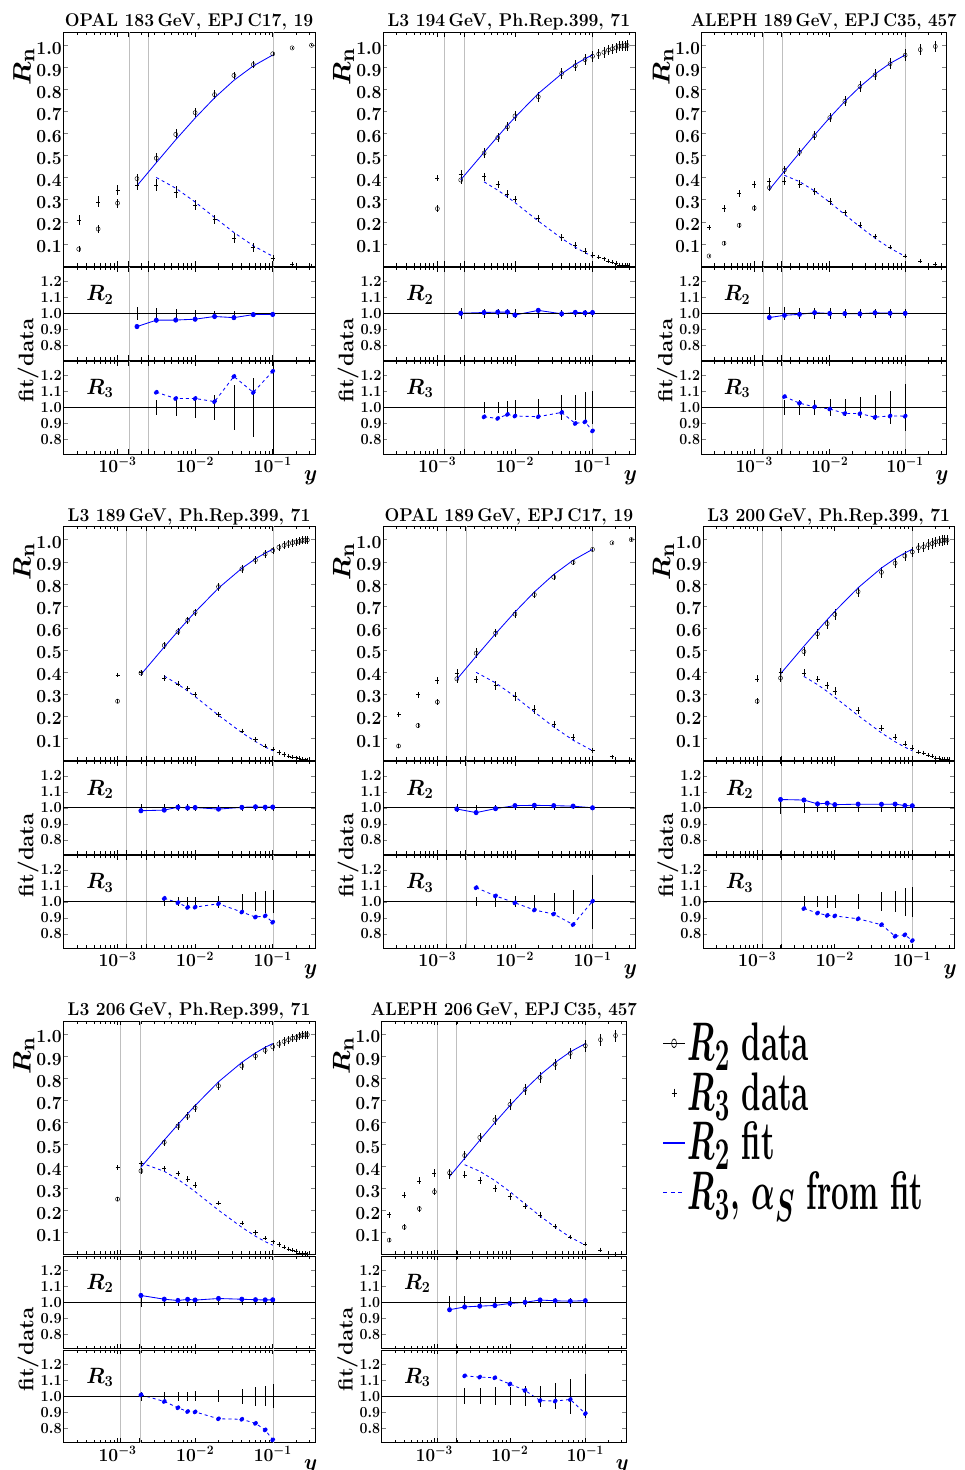
Figure 3 . Comparison of data and perturbative predictions supplemented by hadronization cor- rections in the H L model using for the strong coupling the value obtained from our global (cid:12)t, eq. (4.2).